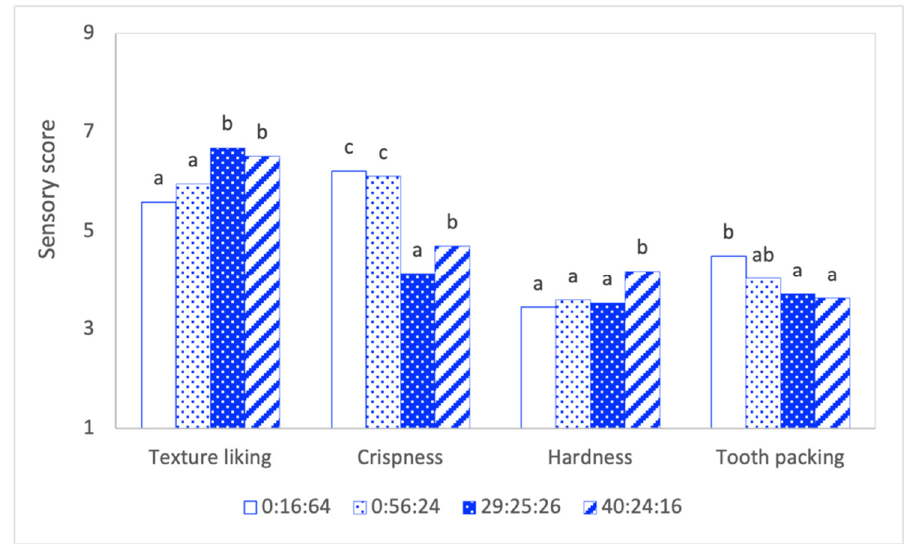
Figure 9. Mean score of the sensory attributes of selected snacks with different proportions of flours (%okara: %mung bean: %rice). a–c Means with different letters within the same response are different ( p < 0.05; n = 3).